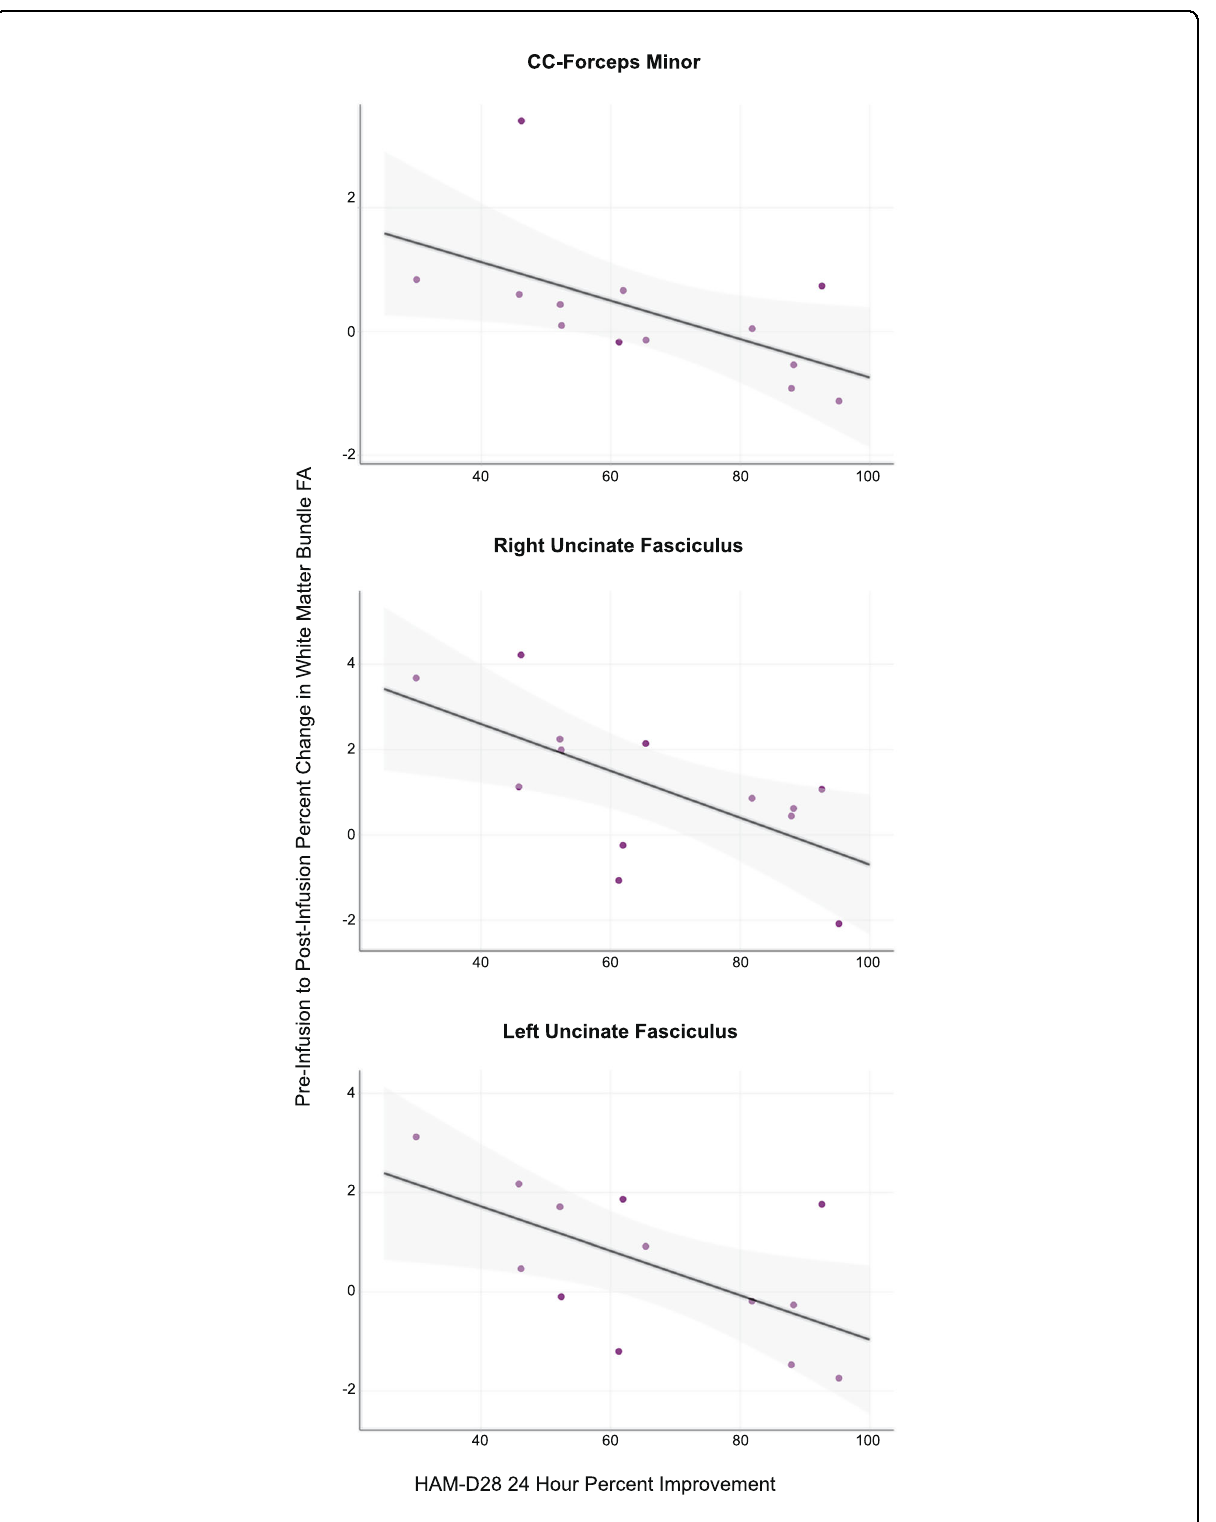
Fig. 3 Pre-infusion to post-infusion white matter bundle FA percent change and depression improvement. The relationship between the percent change in white matter FA from pre- to post-infusion and clinical improvement at 24 h shown for the corpus callosum-forceps minor and the left and right uncinate